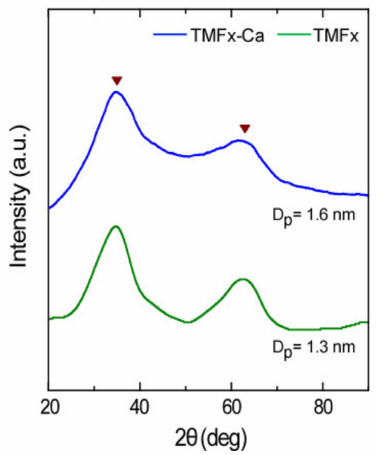
Figure 1. XRD diagrams of TMFx and TMFx-Ca adsorbents. Triangles indicate the